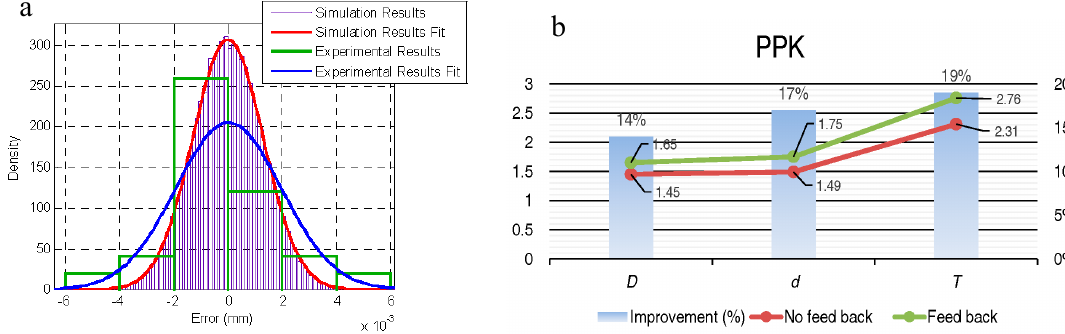
Figure 8. ( a ) Comparison between the results obtained using the Monte Carlo simulation and those obtained experimentally. ( b ) PPK results after applying the process measurement methodology modeled in this work for the external diameter of the outer ring of the bearing ( D ); and results obtained after applying this methodology to the internal diameter of the inner ring ( d ) and to the thickness ( T ). “ D ”, “ d ” and “ T ” according to Figure 1b.